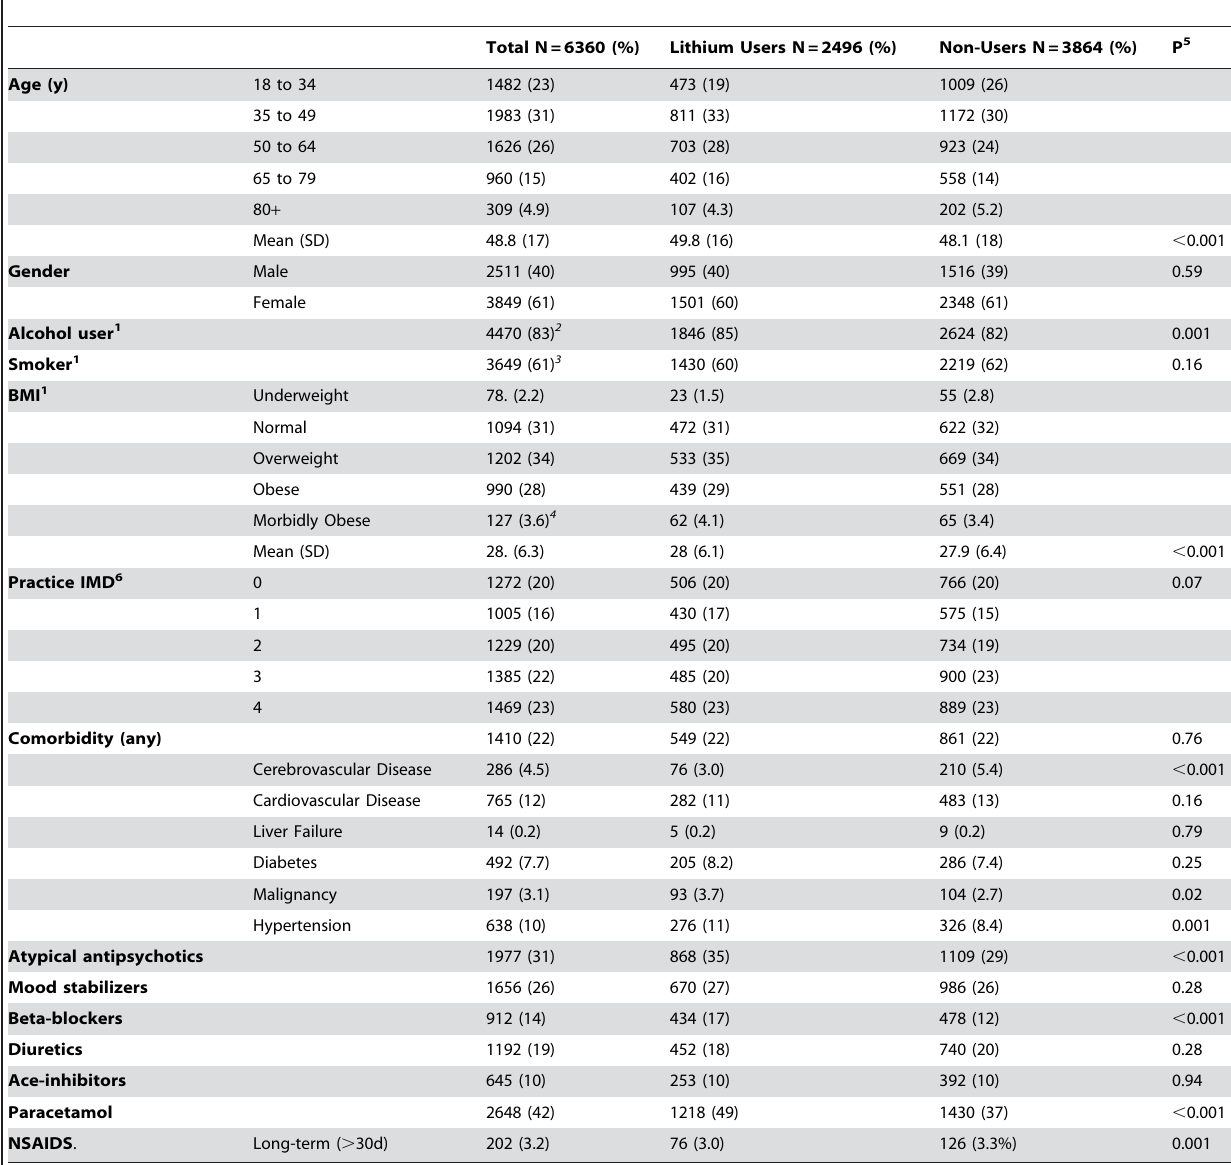
Table 1. Cohort baseline and emergent characteristics at diagnosis of bipolar disorder, according to use or nonuse of lithium.